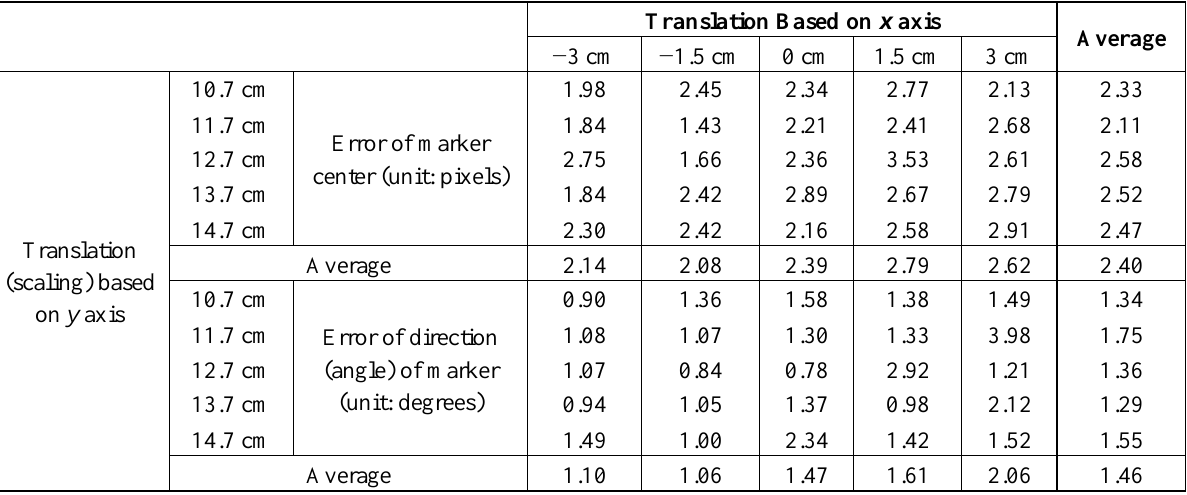
Table 3. Detection error results in case of the translation of device based on x - and y -axes, respectively. Translation Based on x axis